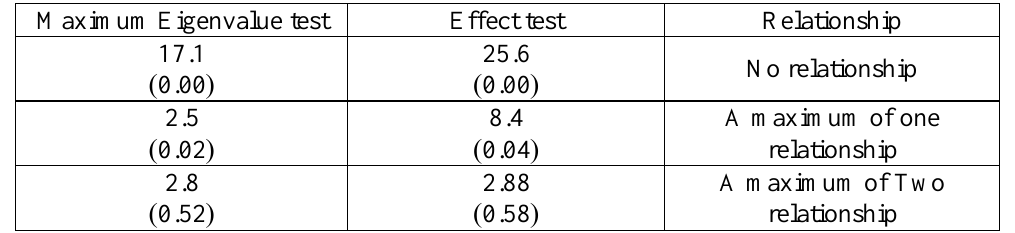
Table 4. The results of the Johansen & Juselius cointegration test